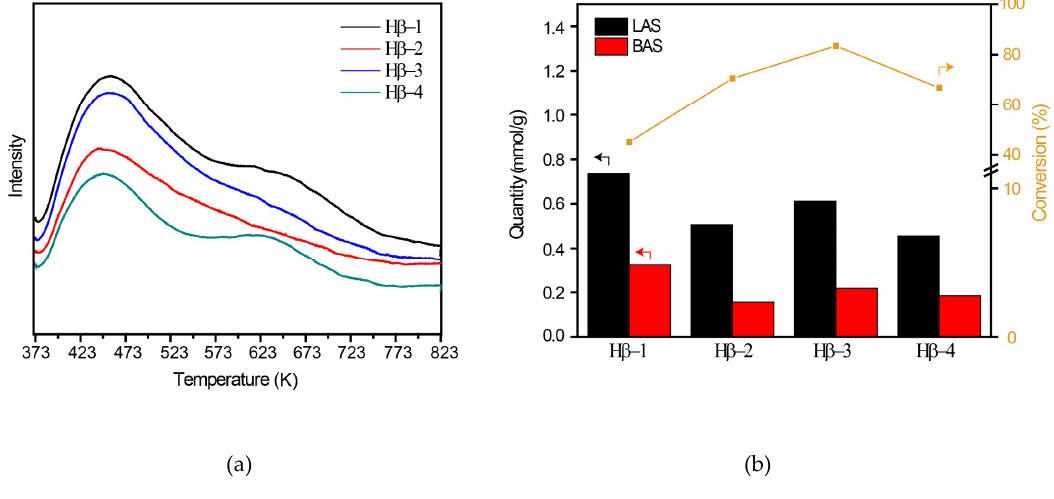
Figure 4. ( a ) NH 3 -TPD profiles of samples from H β -1 to H β -4. ( b ) The correlations between di ff erent acidity site amounts, possible Brönsted acid sites (BAS) and Lewis acid sites (LAS) with catalytic activity in benzylation of p -xylene. The conversion was based on benzyl